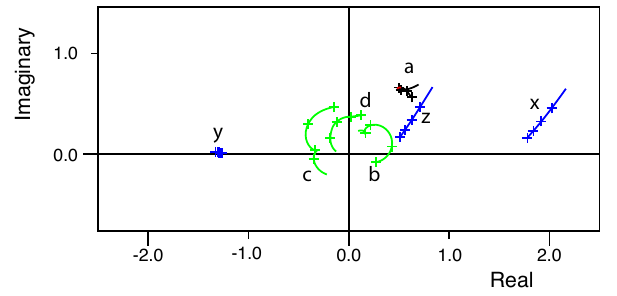
Fig. A1. Components of response function at Portishead between 4 and 8radday − 1 . Crosses at 4, 5, 6 and 7 rad/day. (a) Full response function with diurnal tidal band in red, (b) resonances B of Table 3, (c) remaining shelf and Rossby resonances, (d) sum of (b) and (c), (x) gravity wave resonances of Table 3 excluding B, (y) waves with real component of angular velocity between 30 and 100radday − 1 , (z) sum of (x) and (y). The sum of (d) and (z) is not plotted but at this resolution it would overlay